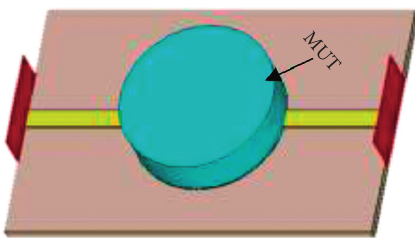
Figure 9: Placement of MUT on the surface of the sensor.